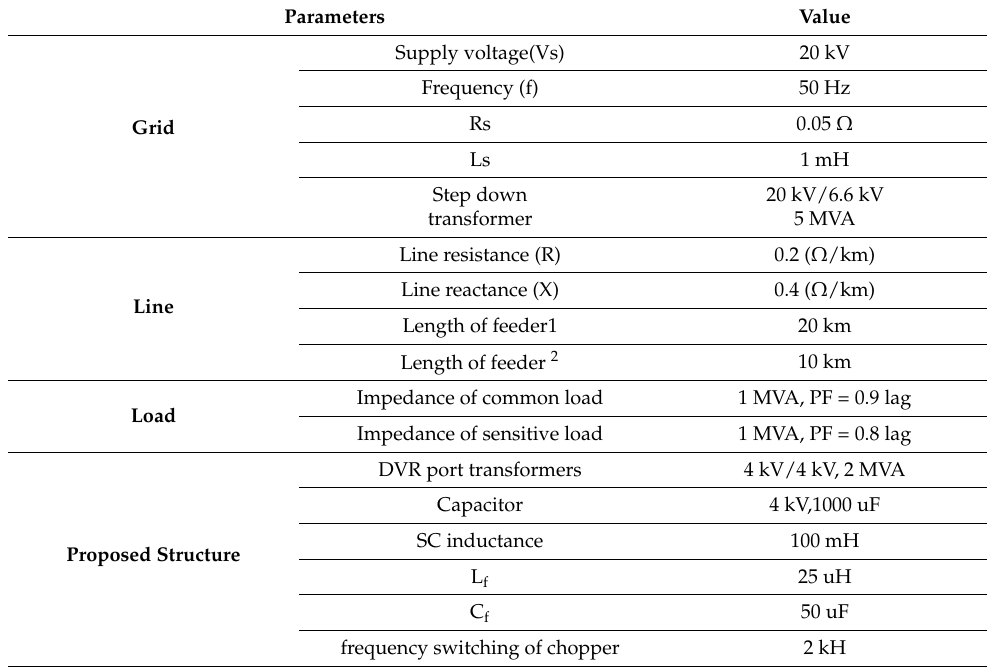
Figure 7. Simulated system. Table 1. Parameters of study